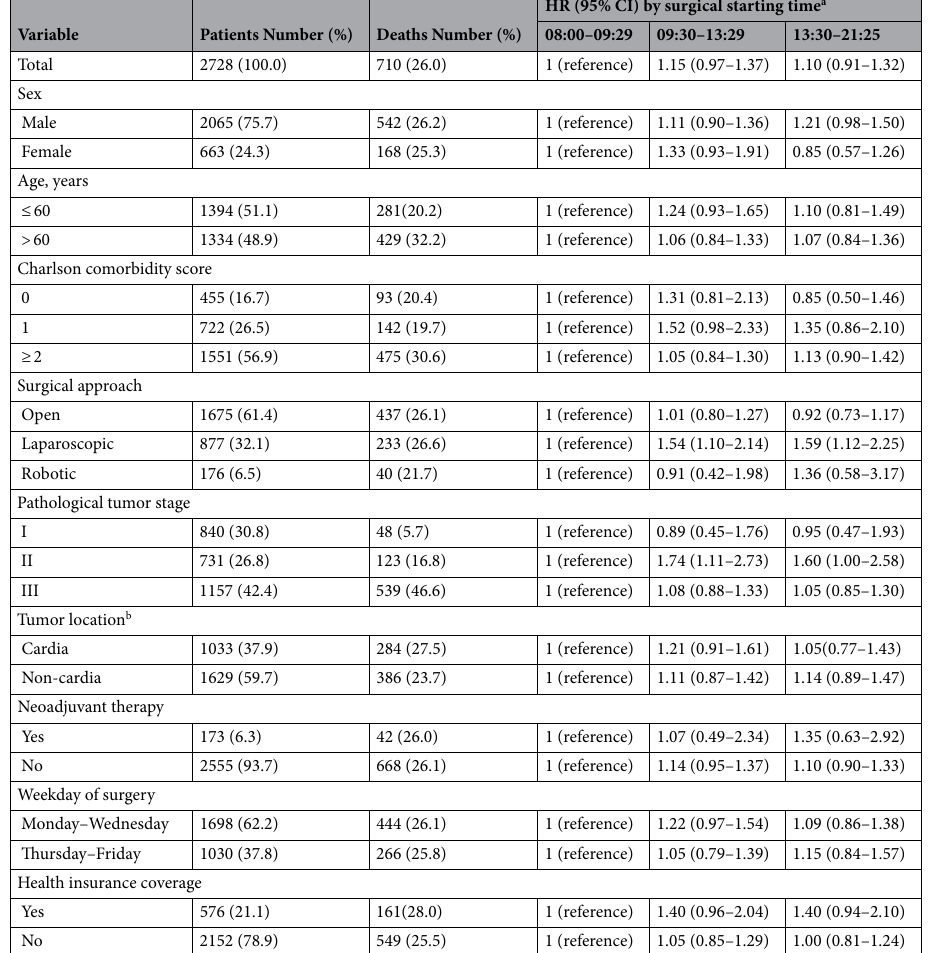
Table 3. Surgical starting time of the day for gastric cancer surgery in relation to 3-year all-cause mortality, presented as hazard ratios (HRs) with 95% confidence intervals (CIs). a Adjusted for age, sex, health insurance coverage, neoadjuvant therapy, pathological tumor stage, surgical approach, weekday of surgery. b 66 cases with tumors affecting multiple anatomical locations were not included in this analysis.